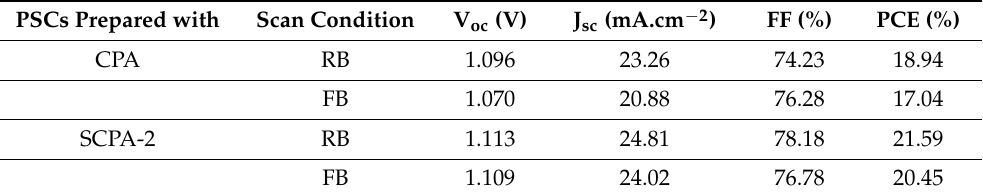
Figure 5. Cross-sectional SEM images of the PSCs prepared with CPA ( a ) and SCPA-2 ( b ). Current– voltage characteristic curves of PSCs prepared with CPA ( c ) and SCPA-2 ( d ). Table 1. Photovoltaic parameters of the as-prepared PSCs under forward bias (FB) and reverse bias